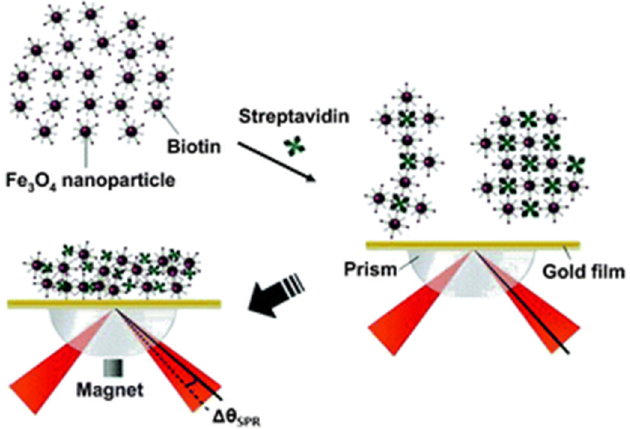
Figure 2. Amplification of the surface plasmon resonance (SPR) response signal with MNPs [47]. Reproduced with permission of the Royal Society of Chemistry.